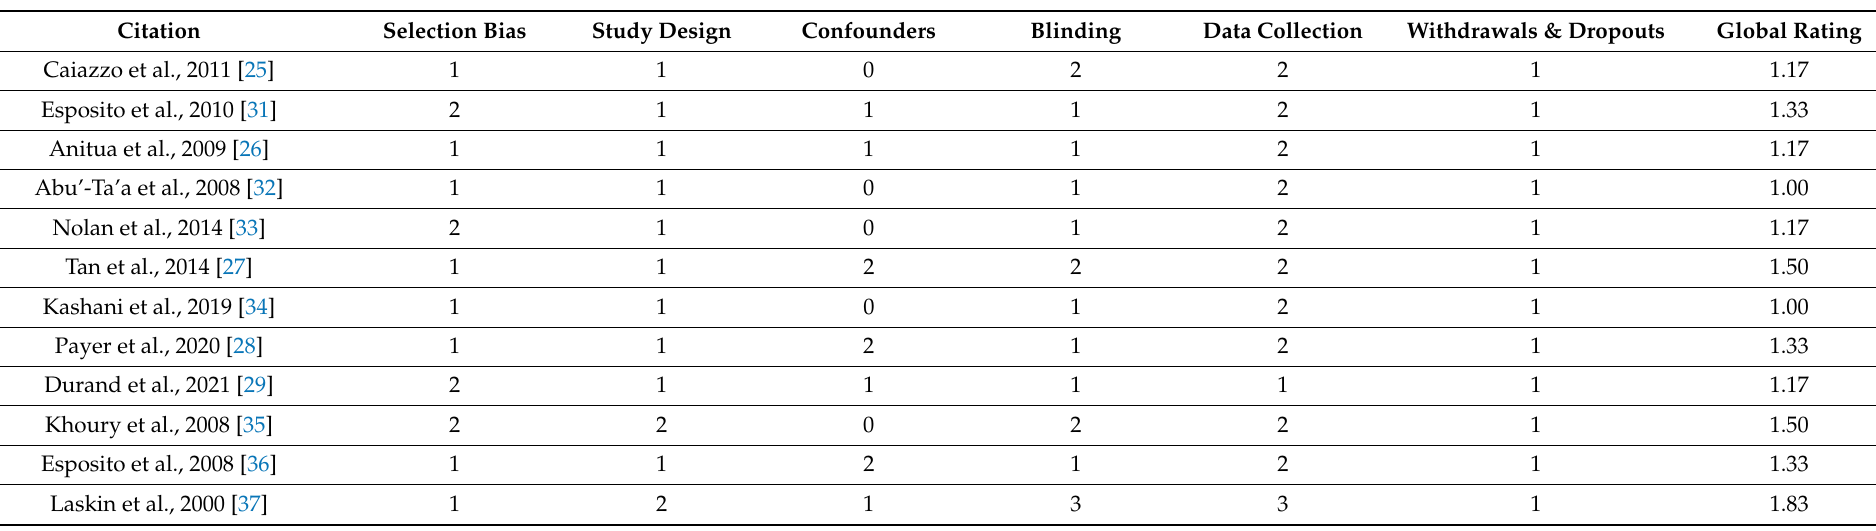
Table 3. Effective Public Health Practice Project (EPHPP) quality assessment tool rating for individual